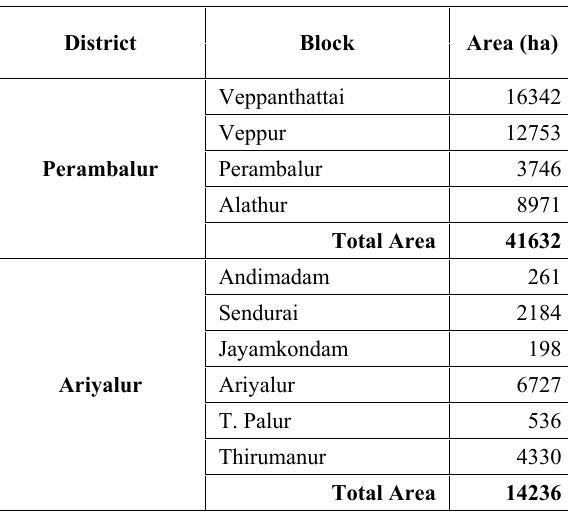
Table 1. Block wise maize area for Ariyalur and Perambalur